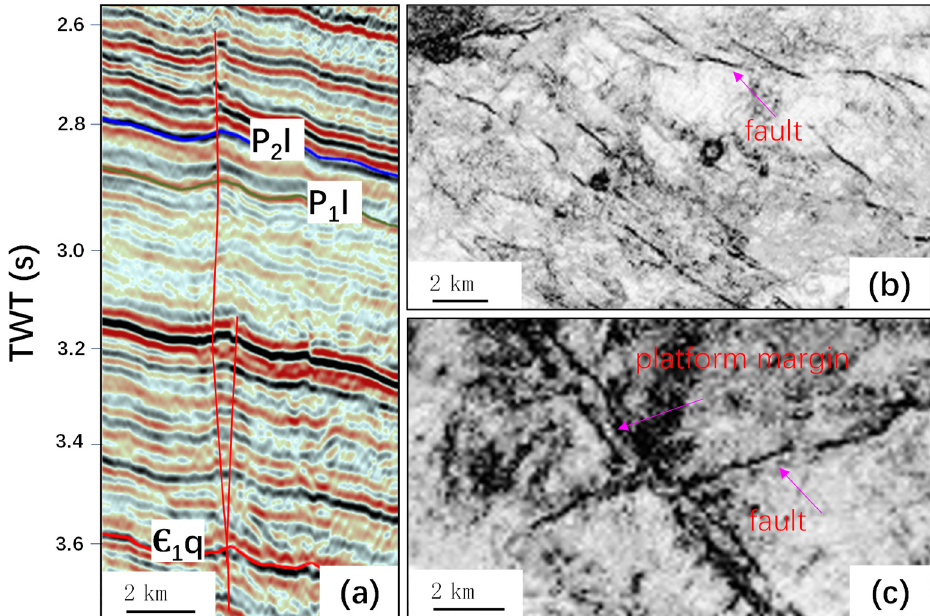
Figure 4. Typical marks of the strike ‐ slip fault in seismic section: ( a ) vertical plane and flower faults at the lower part) and seismic planar coherence attribute; ( b ) en échelon/oblique faults; ( c ) NW ‐ trending platform margin offset by NEE ‐ trending strike ‐ slip fault).